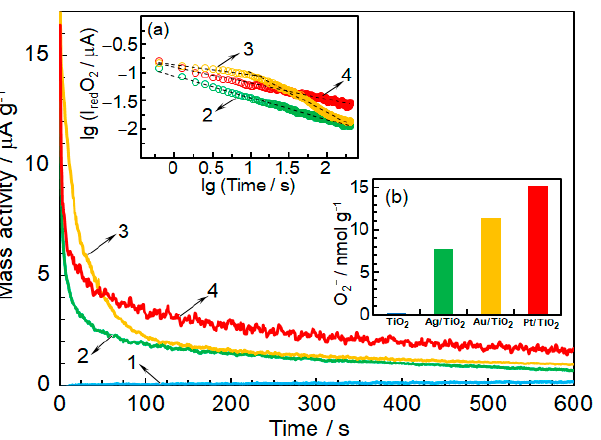
Figure 12. Time-variation of the mass activity for oxygen reduction at pristine TiO 2 (1), Ag/TiO 2 (2), Au/TiO 2 (3), and Pt/TiO 2 (4), at an applied voltage of − 1 V. Insets: ( a ), log–log plots for the oxygen reduction current decay at noble metal-modified TiO 2 ; ( b ), estimated O 2– amounts formed during 10 min of continuous polarization.